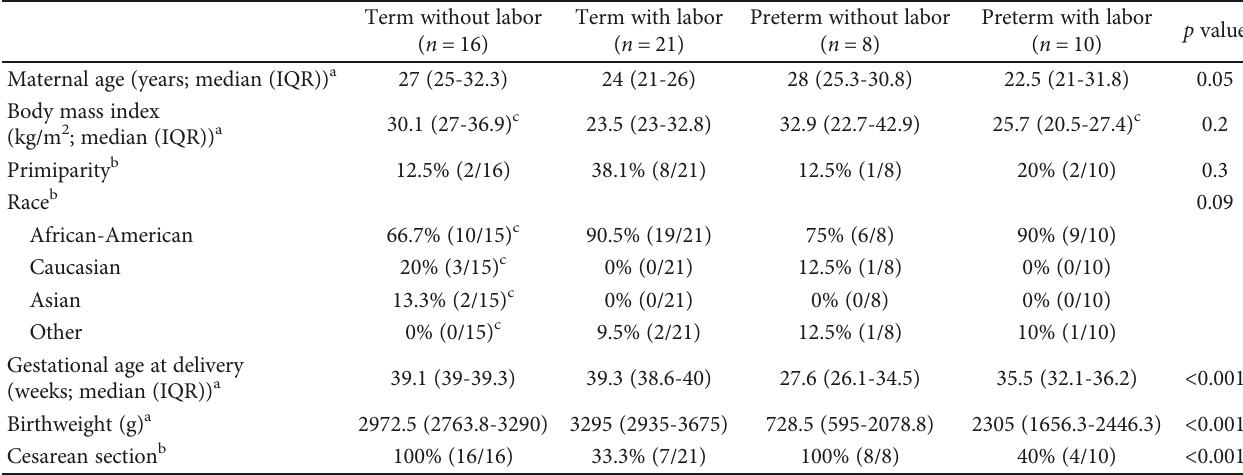
Table 2: Clinical and demographic characteristics of the patient population used to perform immunophenotyping of exhausted and senescent T cells in the decidua